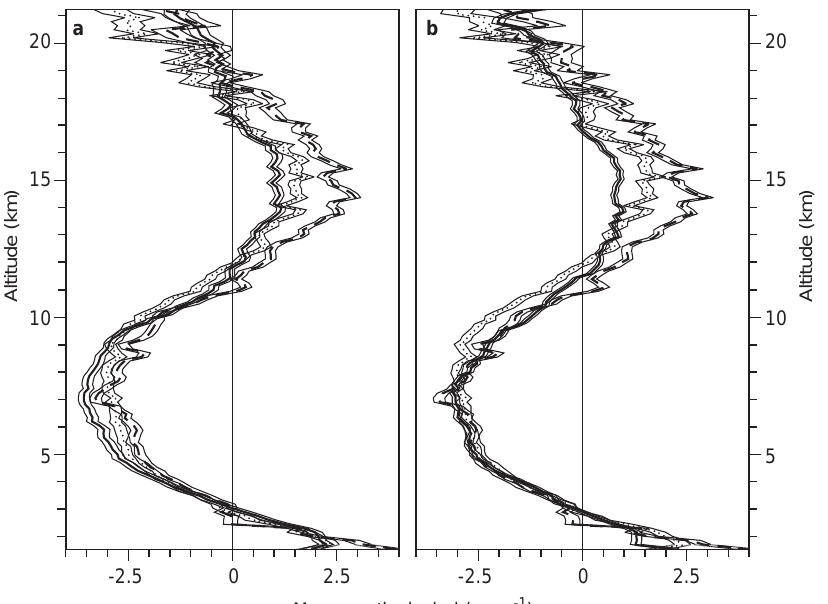
Aberystwyth MST radar is shown in Fig. 10. In addition to the vertical-beam measurement, the NE6 (cid:14) -SW6 (cid:14) and NW6 (cid:14) -SE6 (cid:14) beam pairs are used to calculate W , assuming that W (cid:25) (cid:133) v (cid:135) v (cid:134) = (cid:133) 2 cos 6 (cid:14) (cid:134) and W (cid:25) NE6 (cid:14) SW6 (cid:14) (cid:135) v (cid:134) = (cid:133) 2 cos 6 (cid:14) (cid:134) respectively, where v is the (cid:133) v NW6 (cid:14) SE6 (cid:14) line-of-sight velocity in the relevant beam. In Fig. 10a, (NW6 (cid:14) , NE6 (cid:14) , SE6 (cid:14) , SW6 (cid:14) and vertical) are available,